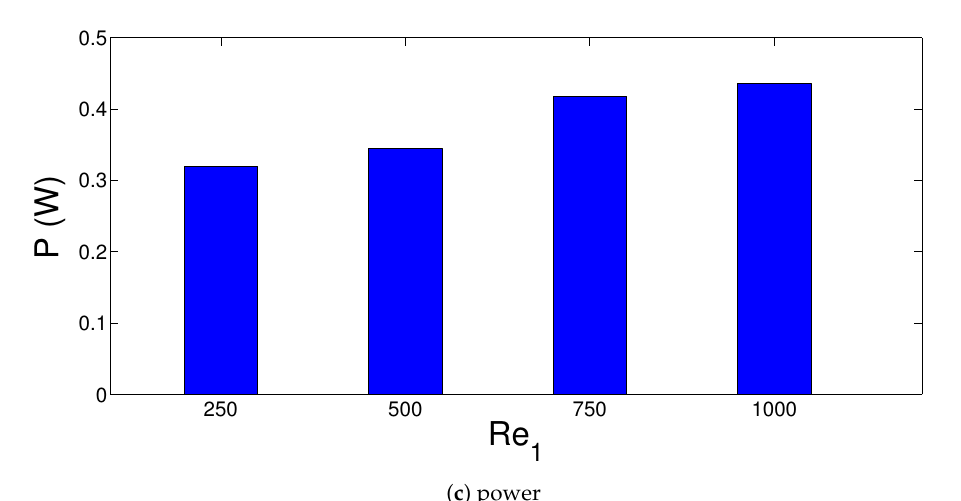
Figure 6. Impacts of hot jet stream Reynolds number on the variation of interface temperatures of the cold and hot side (mid-axis) ( a , b ) and generated TEG power ( c ) (Re 2 = 500, (r 1 ,r 2 ) = (1,1), z h = 3w s , φ = 0.02).